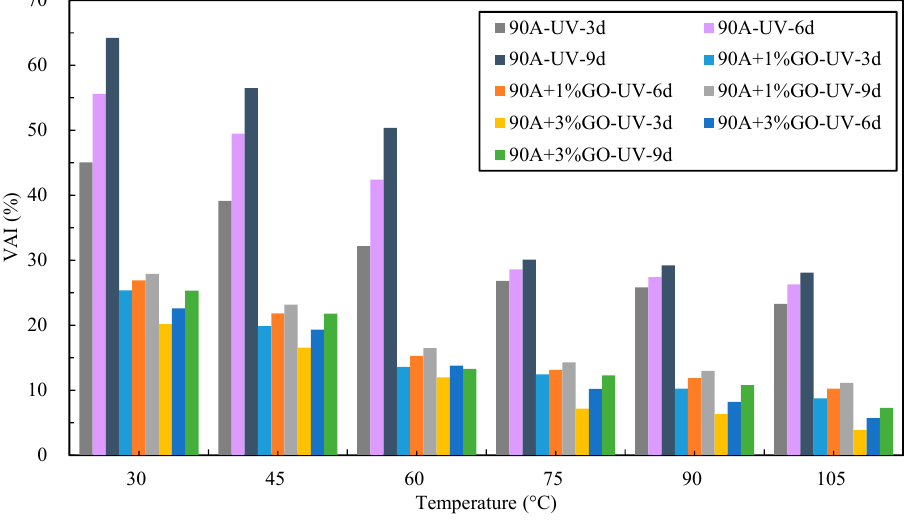
Figure 7. VAI of 90 A and GO modified 90 A after UV aging.